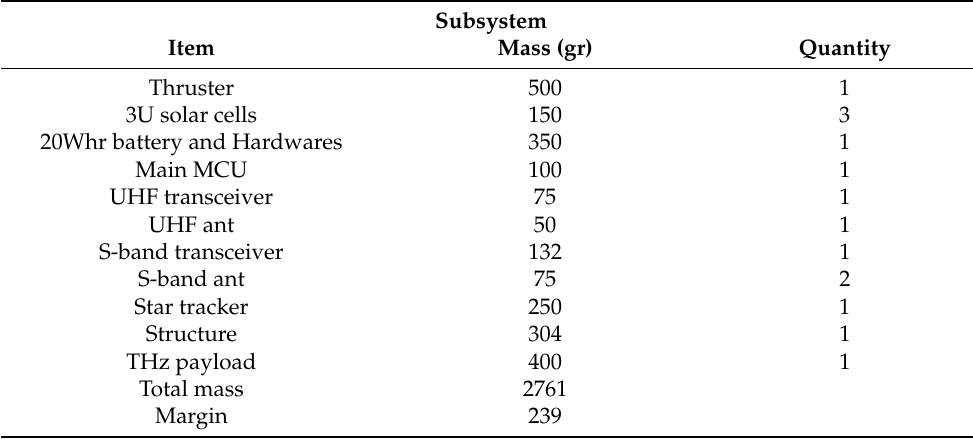
Table 4. CubeSat mass